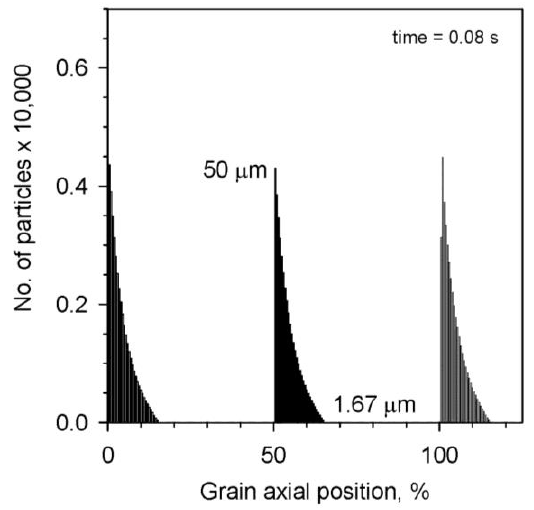
Figure 13. For the simulated firing of Figure 12, the particle size distribution in the element, at different positions along the propellant grain, before the introduction of the initial pressure pulse